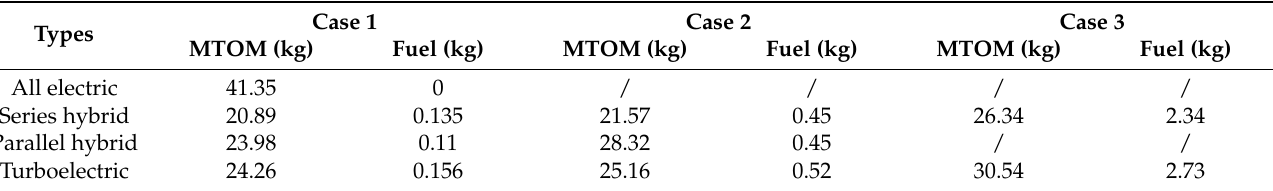
Table 5. Mission profile paraments.